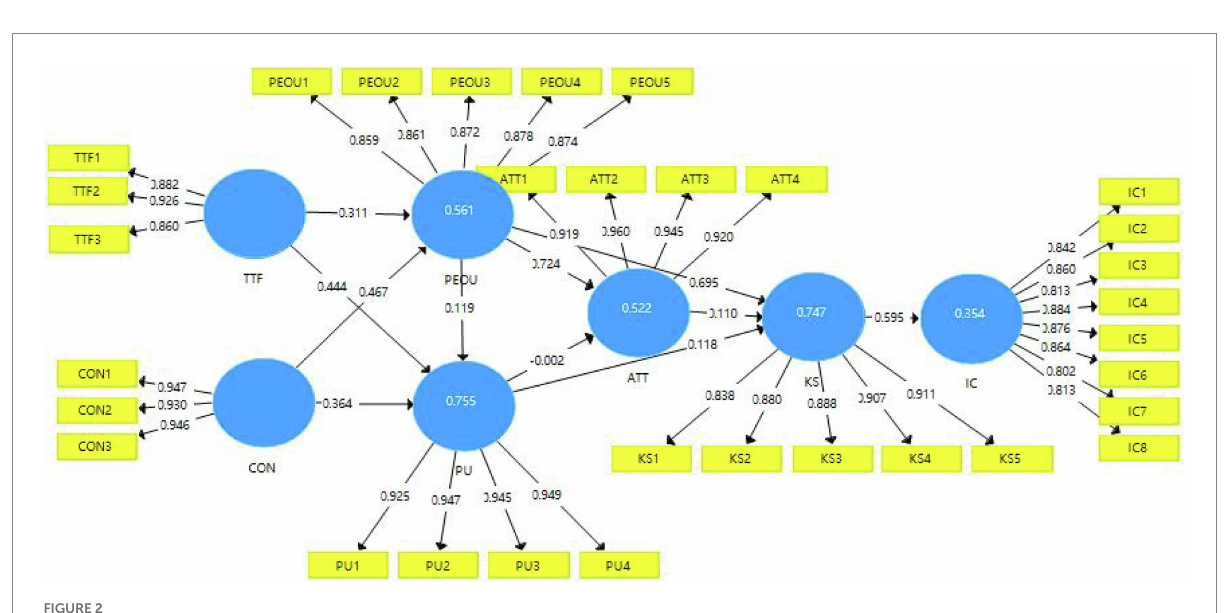
FIGURE 2 Path coefficients of the research